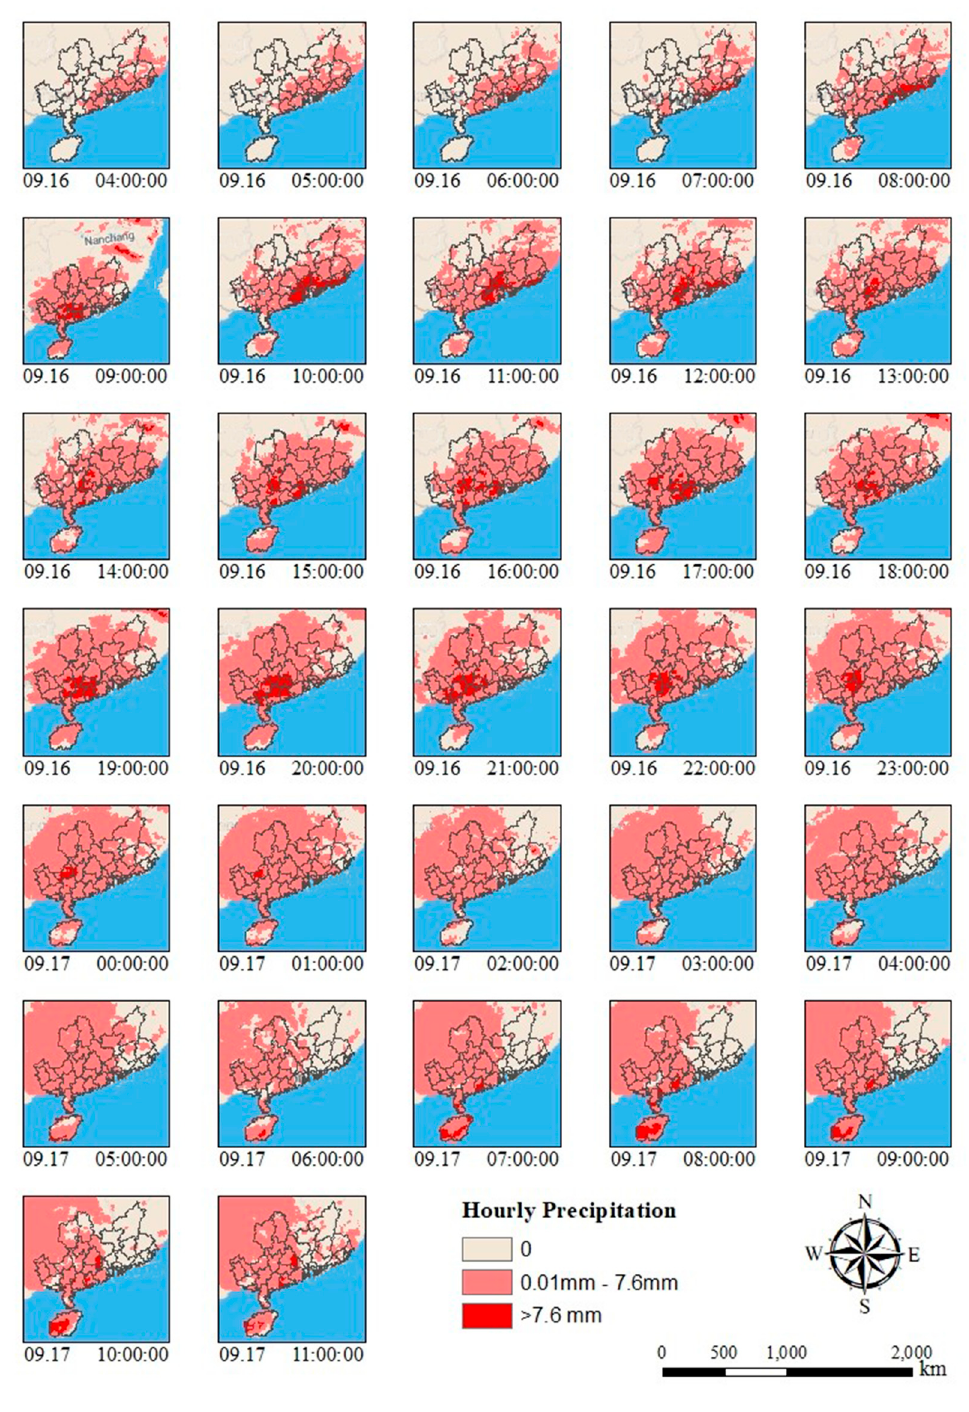
Figure 3. Hourly precipitation schematic of the Typhoon Mangkhut, in China, from 16th September to 17th September.